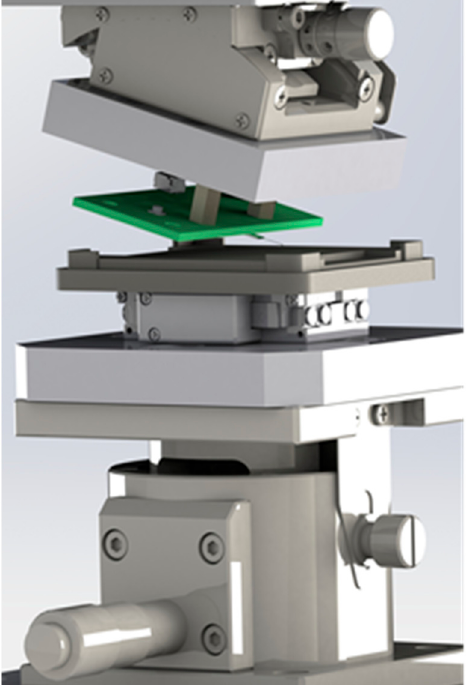
Figure 3. CAD design of the measurement setup. In green, the PCB with the microprobe can be seen.